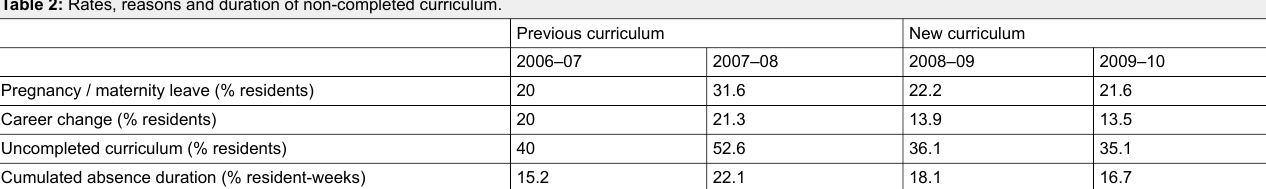
Table 2: Rates, reasons and duration of non-completed